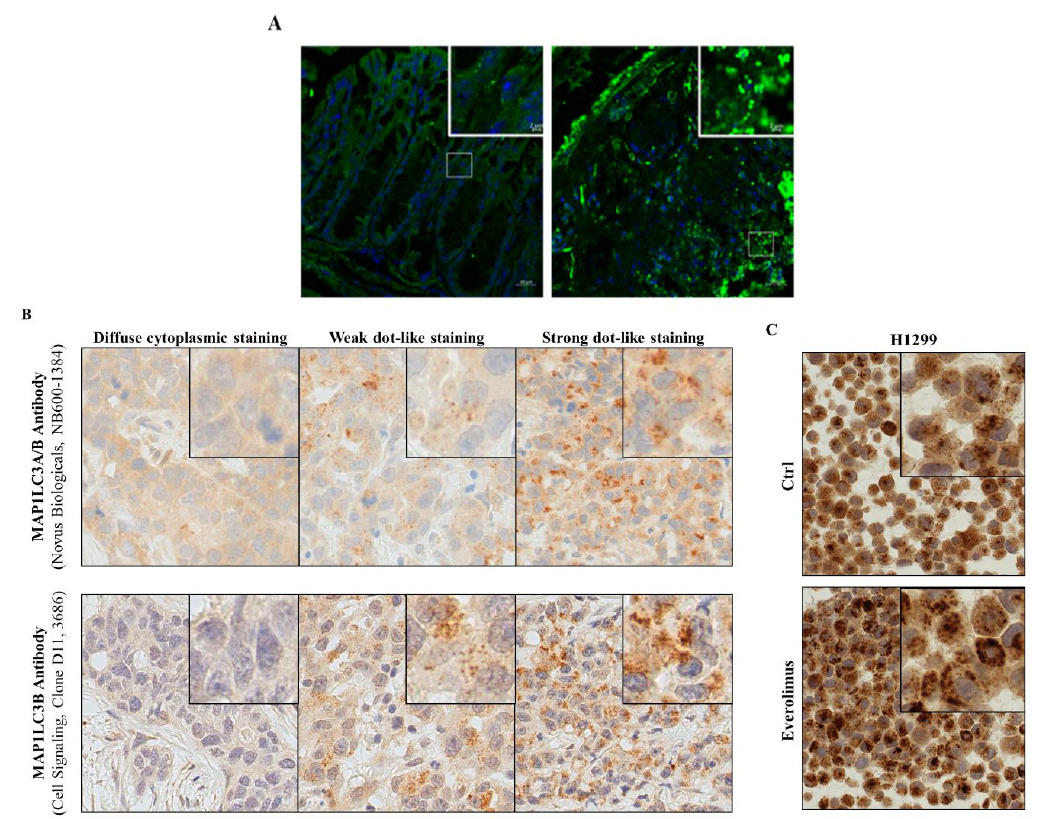
Figure 4. Immunofluorescence for MAP1LC3B. ( A ) Colon tissue sections of a control mouse and a mouse treated by TNBS to induce acute colitis. Staining for DNA with DAPI (blue) and for MAP1LC3 with Alexa-fluor labeled specific antibodies; ( B ) MAP1LC3A / B immunohistochemistry staining of three archived FFPE samples from patients with an adenocarcinoma of the lung. Di ff erent MAP1LC3A / B expression levels were visualized using two di ff erent antibodies, as indicated. ( C ) MAP1LC3A / B immunohistochemistry staining of FFPE-H1299 NSCLC cells that were either left untreated (Ctrl) or treated with everolimus, a selective inhibitor of MTOR activity used to stimulate autophagy.